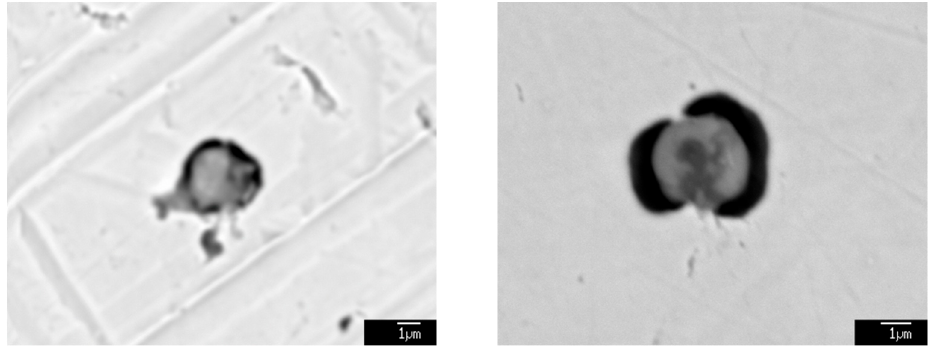
Figure 12. The morphologies of typical Ti-oxide-containing inclusions in the final products. Table 4. The chemical composition of typical Ti-oxide-containing inclusions in the final products.